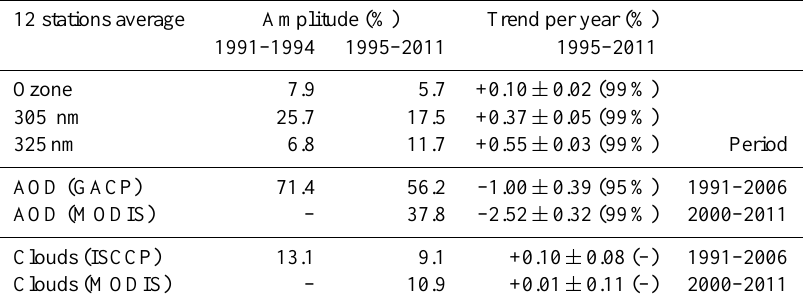
Fig. 3. White noise residuals (left panels) and their CUSUMs ( ε t , right panels) for all stations average. The red dotted line indicates the negative part of the 95% confidence envelope of departures from natural variability and model uncertainty. Table 2. Amplitude (i.e., (max–min)/2) of atmospheric parameters during 1991–1994 (volcanic period) and during 1995–2011 (post-volcanic period). The right column shows the trends in per cent per year averaged at the 12 stations. Values in brackets refer to statistical significance of each